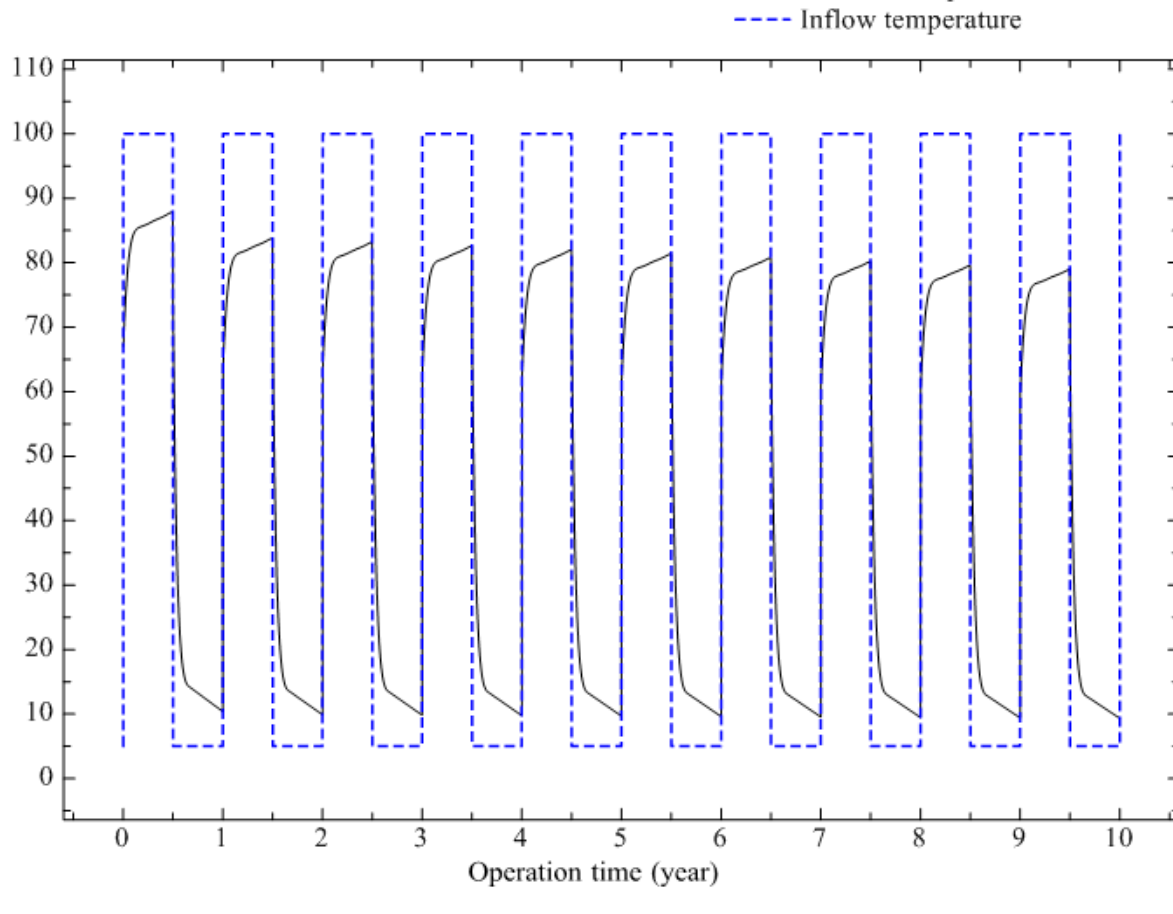
Figure 19. Outlet temperature of the deep BTES system during ten years cyclic operation (operation hours ratio of charging and discharging is 1:1).